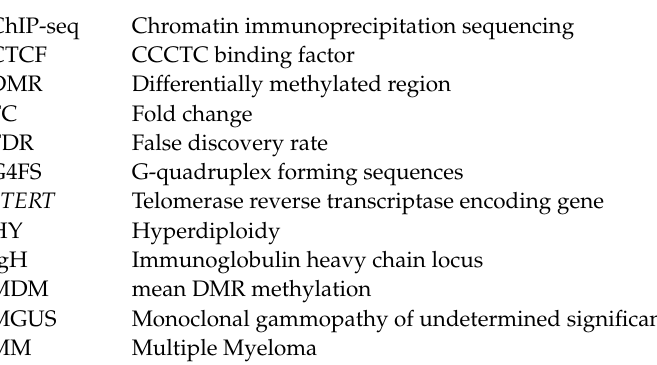
Table S3: Differential methylation across the promoter and the body of TRGs in t(4;14) subgroup, Table S4: Differential methylation across promoter and body of TRGs in t(11;14) subgroup, Table S5: Differential methylation across promoter and body of TRGs in t(14;16) subgroup, Table S6: Differential methylation across promoter and body of TRGs in t(14;20) subgroup, Table S7: Differential methylation across promoter and body of TRGs in D1 subgroup, Table S8: Differential methylation across promoter and body of TRGs in D2